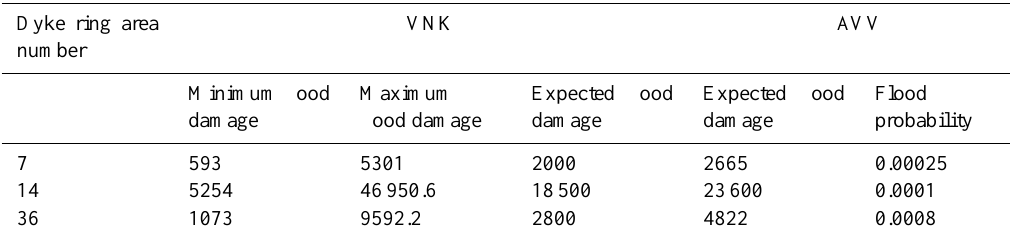
Fig. 2. Safety standards of dyke ring areas in the Netherlands (Source: TAW, 2000). Figure 2: Safety standards of dyke-ring areas in the Netherlands ( Source : TAW, 2000 ) Table 1. Example of flood damage information for three dyke ring areas provided by the VNK and AVV flood risk studies in the Nether- lands (damage in million